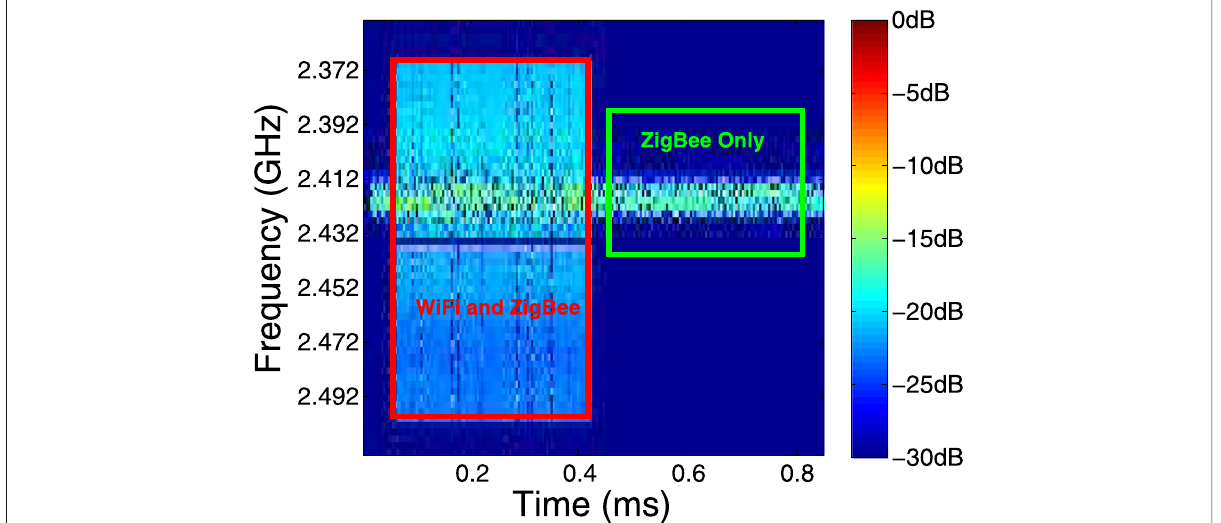
Fig. 12 The different packet lasting time between WiFi and ZigBee provides the opportunity to identify the interfered